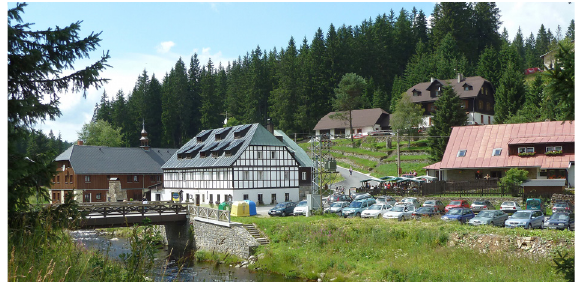
Fig. 4. Modrava: rural seats in the Šumava Mts. were transformed into tourist destinations. Photo by A. Vaishar.